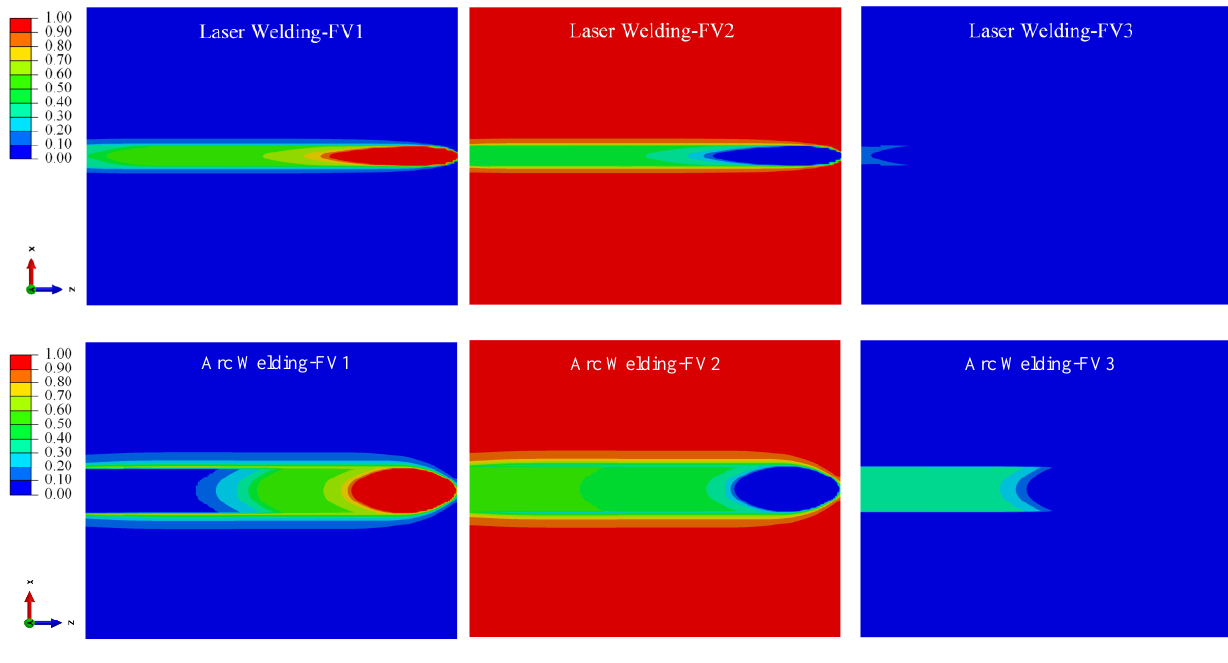
Figure 19. With the heat source moving to 100 mm from starting position, change of volume fraction of phase composition in weld bead.